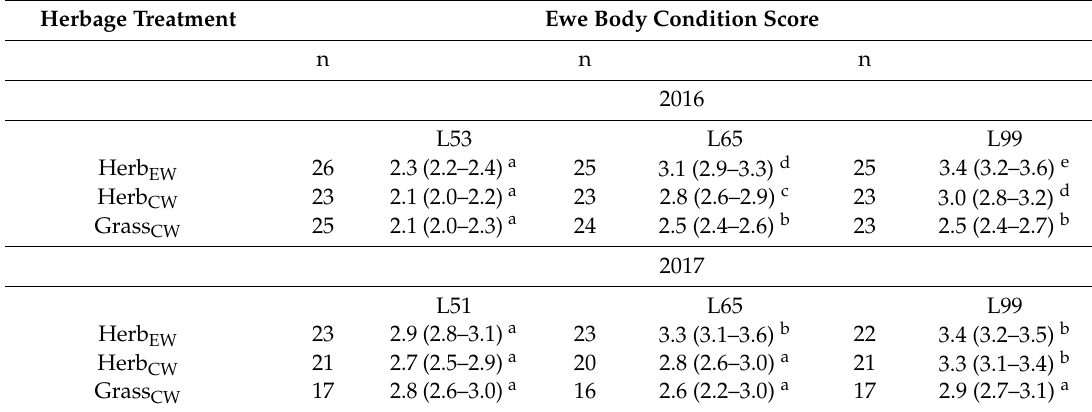
Table 4. Body condition score of ewes in the Herb EW , Herb CW and Grass CW treatments at L53, L65, and L99 in 2016 and at L51, L65, and L99 in 2017 (Results displayed as back transformed logit mean and 95% confidence